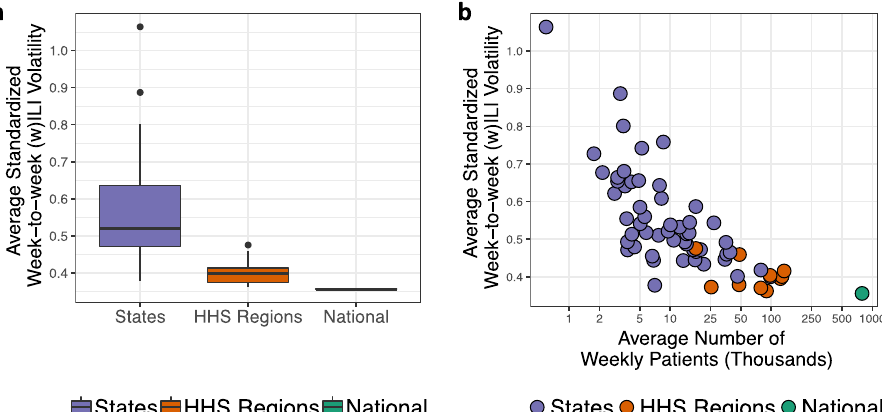
Fig. 3 Standardized volatility by geographic scale. a Average standardized week-to-week in fl uenza-like illness (ILI — states) and weighted ILI (wILI — HHS regions and nationally) volatility for three geographic scales. Volatility decreases as the scales coarsen. Boxplots present median (center line), interquartile range (boxes), 1.5 times the interquartile range (whiskers), and outliers (points) based on n = 53, 10, and 1 observations for states, HHS regions, and the nation respectively. b Average standardized week-to-week (w)ILI volatility versus the average number of weekly patients on a log scale for each state, HHS region, and nationally. Volatility decreases as the number of weekly patients seen increases, suggesting that volatility is in part a product of ILINet